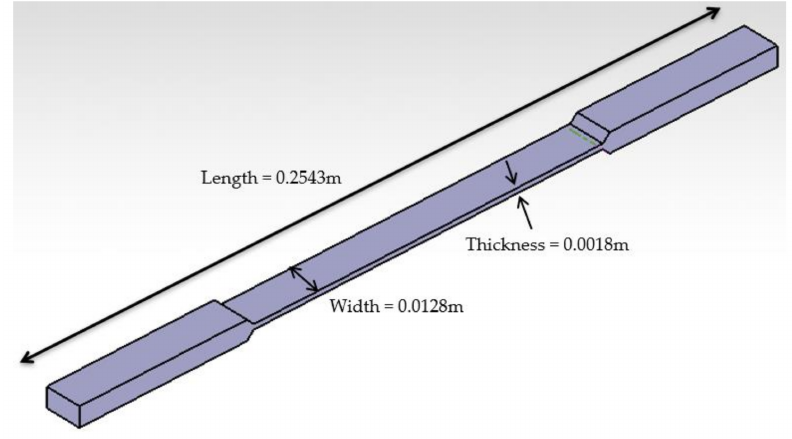
Figure 1. Dimensions of specimen (0.2543 m × 0.0128 m × 0.0018 m).